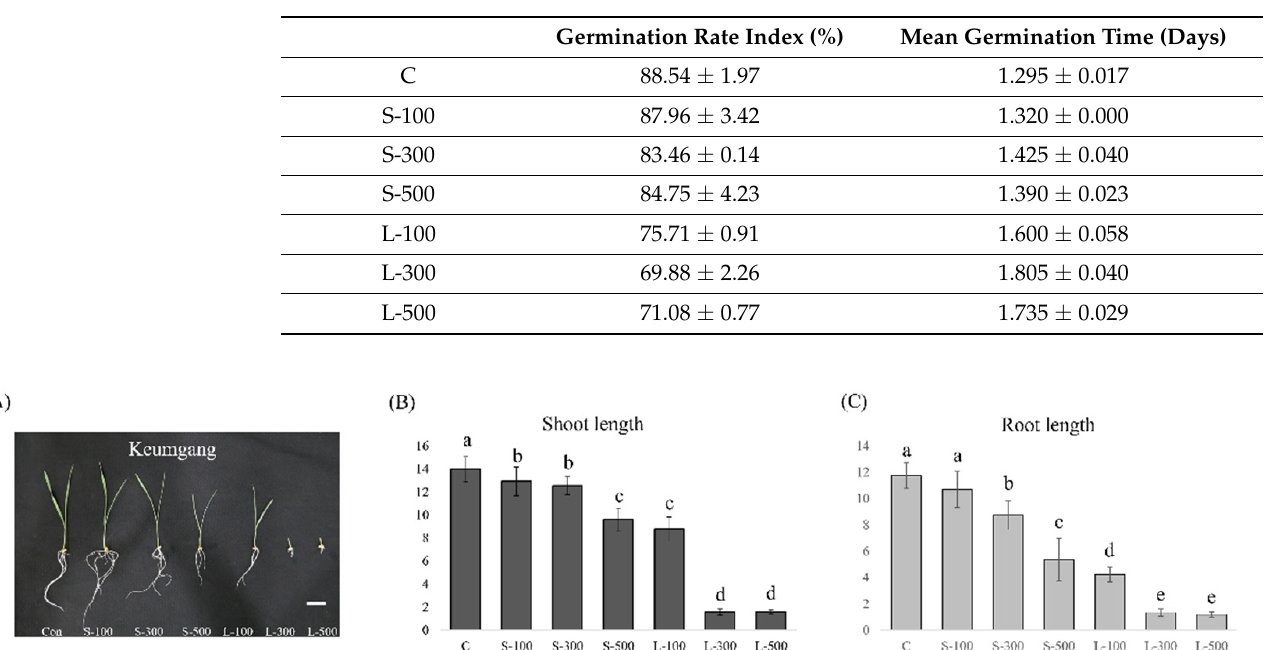
Table 1. Germination rate index and mean germination time according to the dose of and time of exposure to gamma radiation.